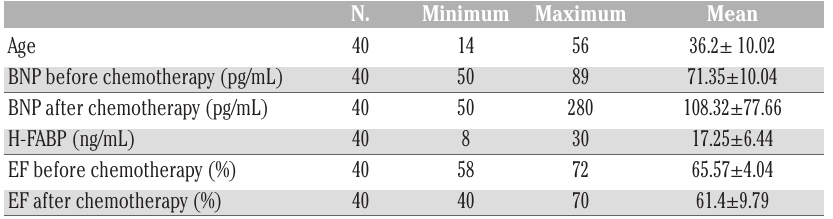
Table 1. Biochemical markers and ECHO findings in our patients.